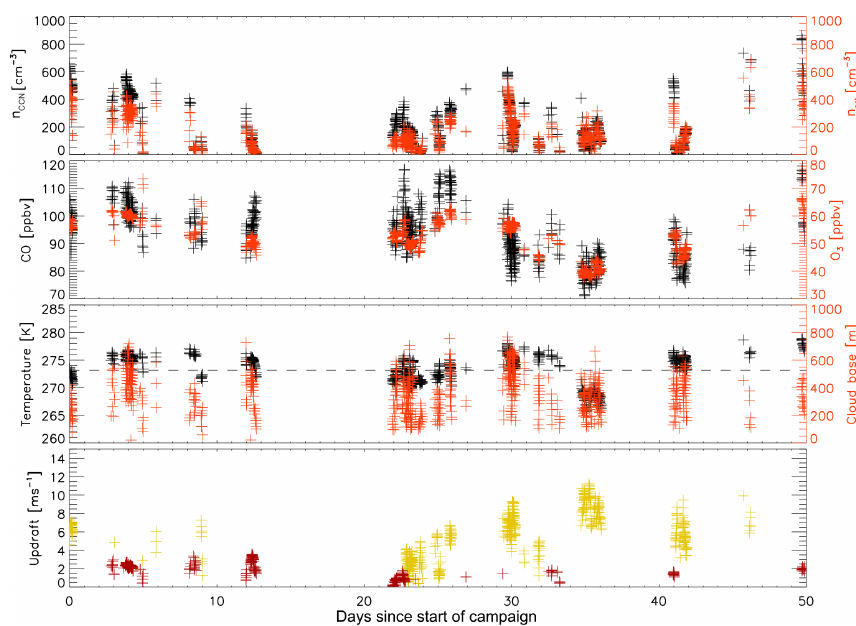
Figure 1. Time series for several quantities measured directly during the CLACE2011 campaign or derived from other CLACE2011 data. The number of CCN, shown in the top panel, refers the number of particles larger than 80nm in diameter, which are considered potential CCN in constructing the statistical models (see text). In the bottom panel, the colour of the points indicates the wind direction, with yellow showing wind classified as being northwest and red southeast. Data are only plotted for times when the JFJ was in